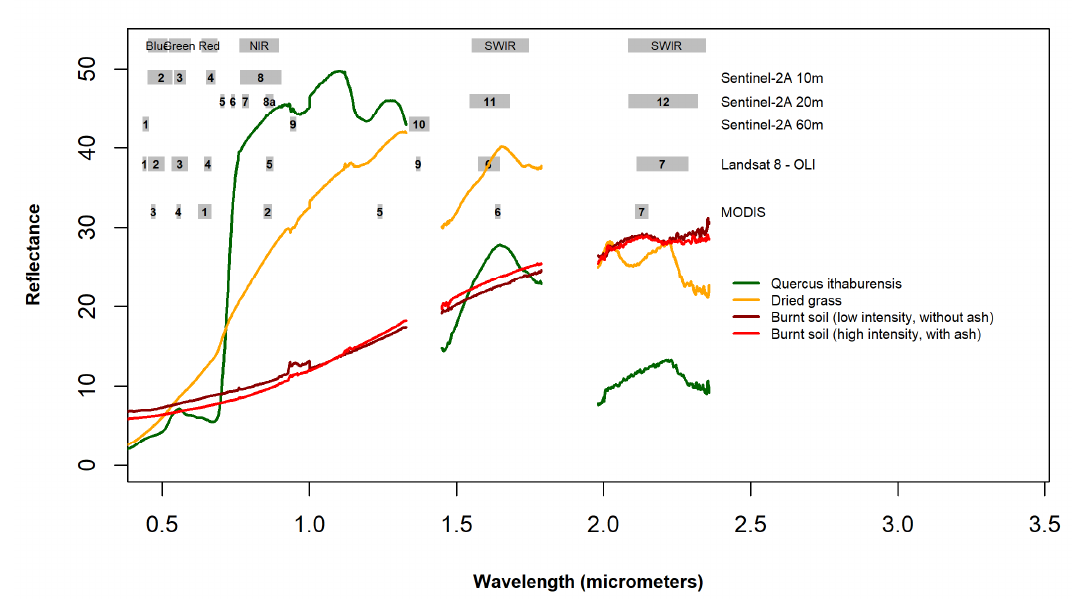
Figure 3. Spectral channels of Landsat, Sentinel-2, and MODIS sensors. The numbers in the grey boxes correspond to the numbers of spectral channels of each satellite.